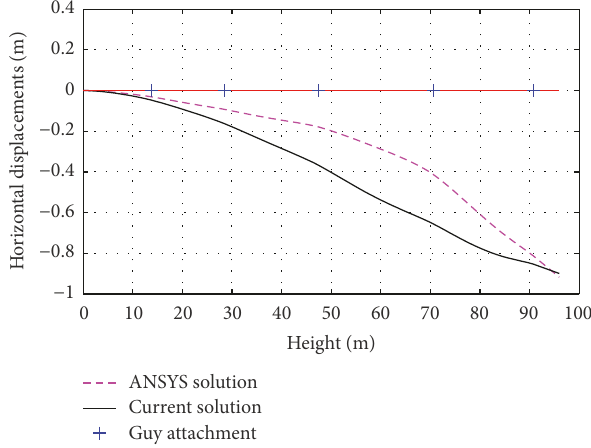
Figure 3: Comparison of the idealized solution with the Ansys